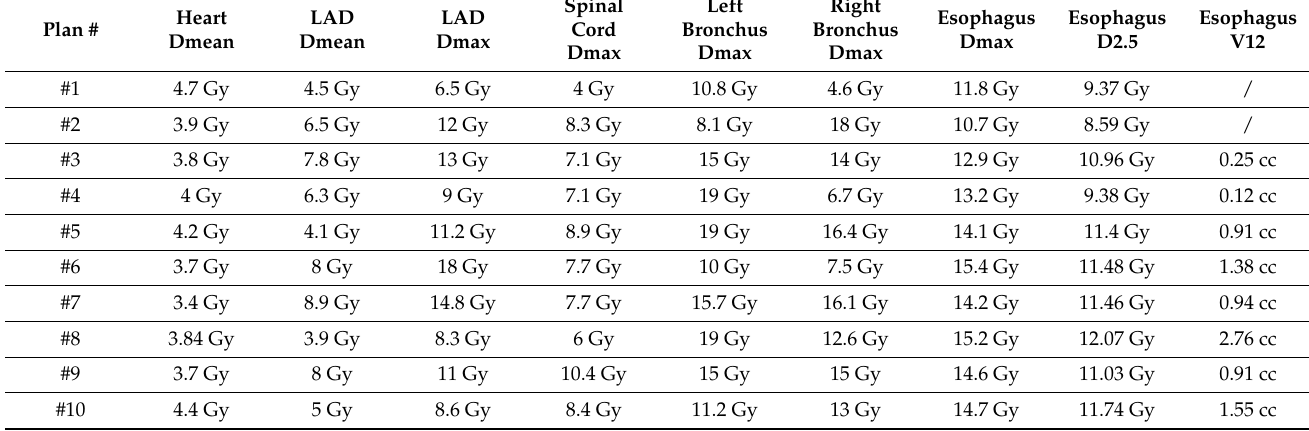
Table 3. Dose constraints of Organs at